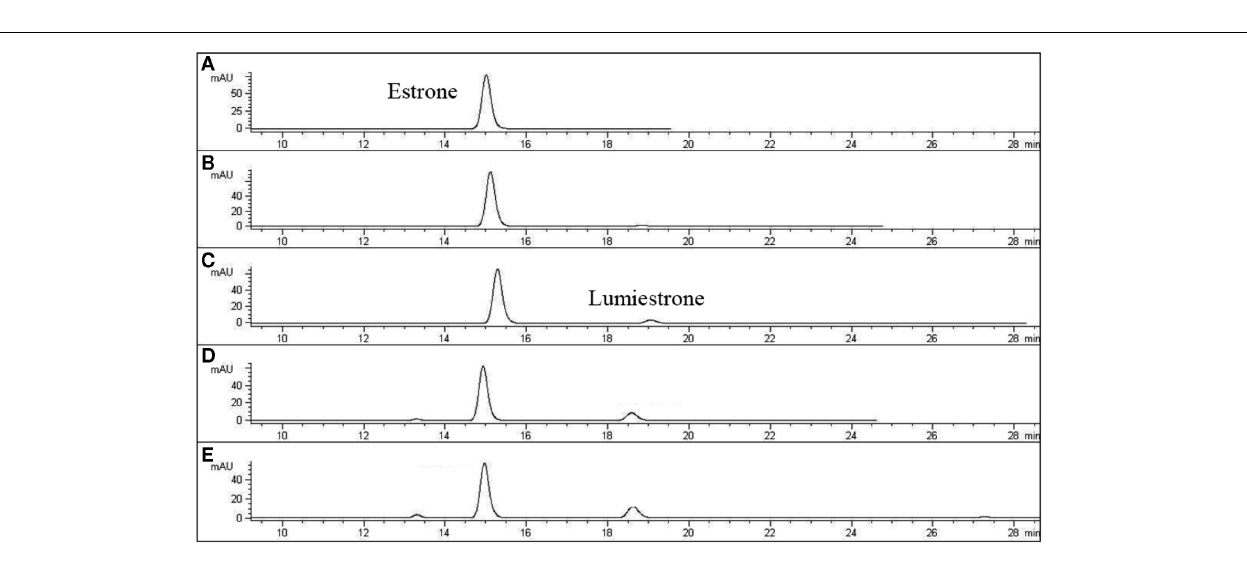
Frontiers in Endocrinology | Experimental Endocrinology December 2011 |Volume 2 | Article 83 |